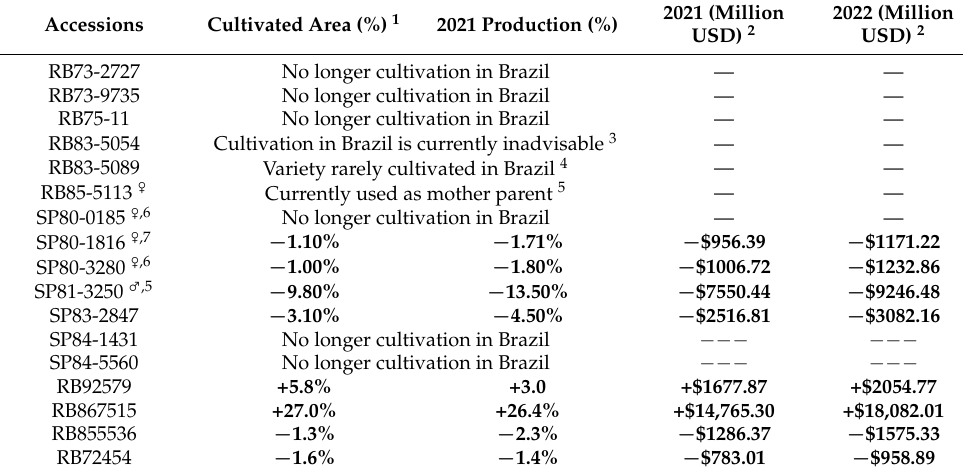
Table 4. Brazilian accession of sugarcane harvest in 2021 and